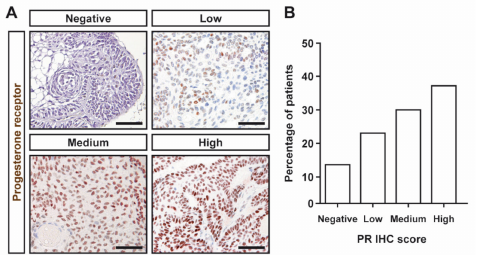
Figure 2. Immunohistochemical detection of progesterone receptor (PR) in CPs assessed by immuno- histochemistry. ( A ) Representative pictures of PR immunohistochemical categories in CPs. Negative, no, or only cytoplasmic immunoreactivity, IRS 0–1; low, IRS 2–3; medium, IRS 4–8; and high, IRS 9–12. Scale bar: 50 µ m. ( B ) Percentage of patients with CPs for IHC